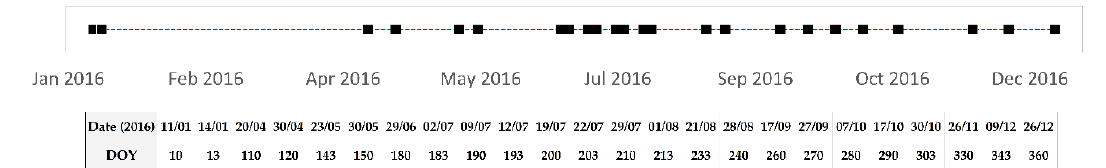
Figure 2. Acquisition dates of S2 L1C images used in this study. Reported timeline shows image availability along the year. Missing dates correspond to cloudy days. Dates are also associated to the DOY (day of the year) indicating the number of days from 1 January 2016.